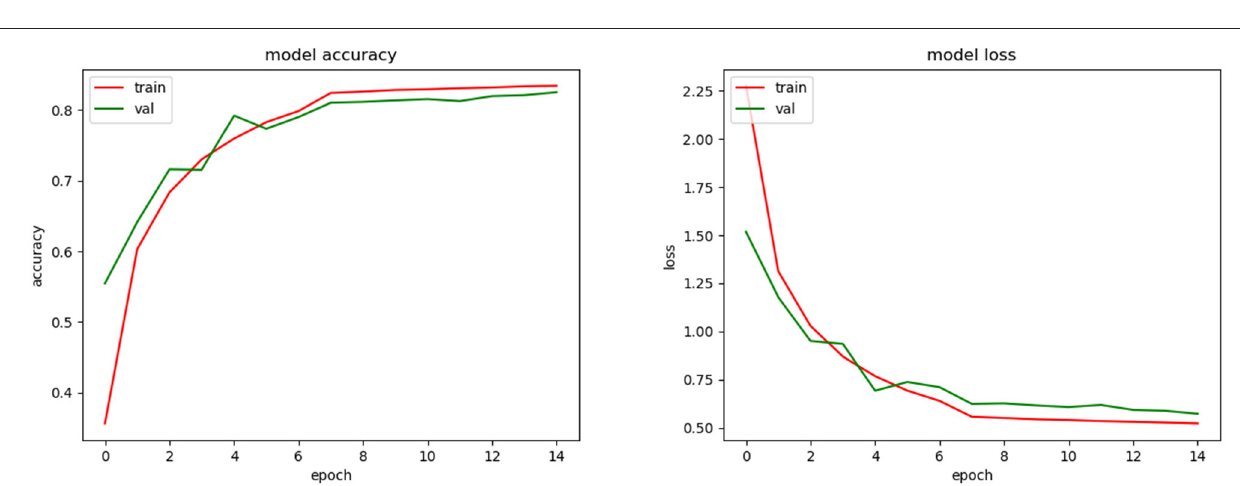
magnification and will have that feature in the near